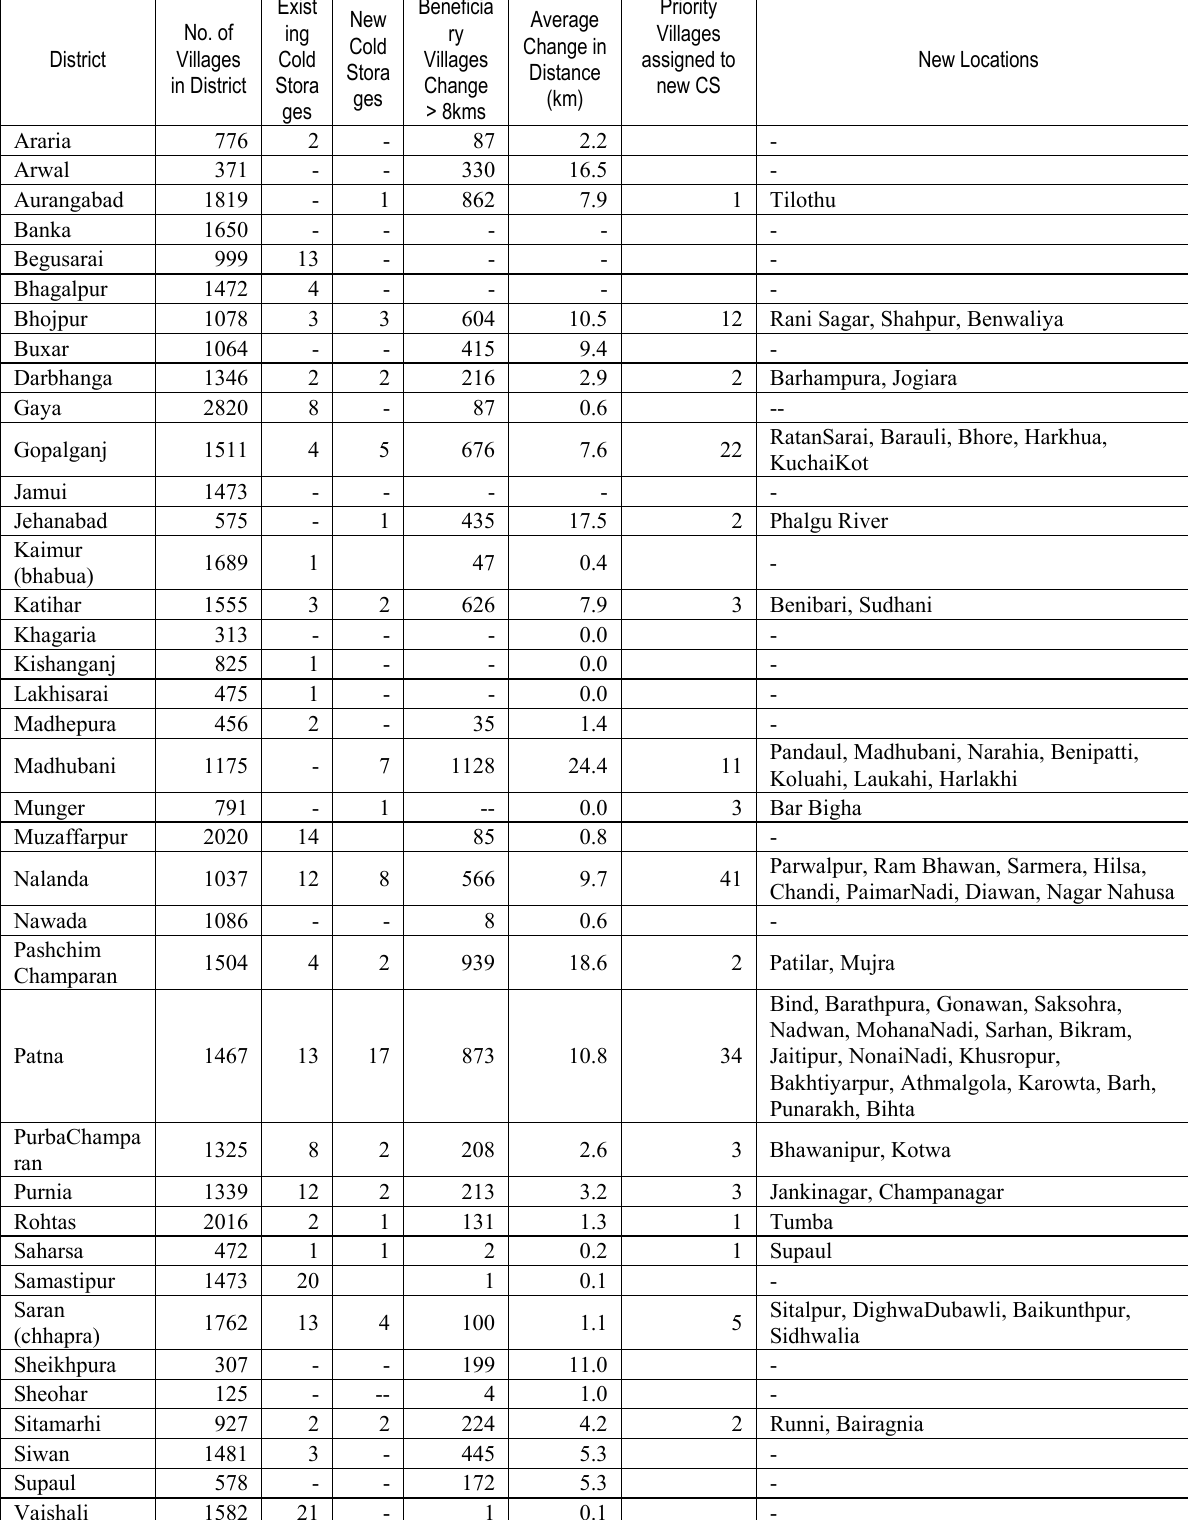
Table 1: Details of suitable sites for positing new cold storage facility and